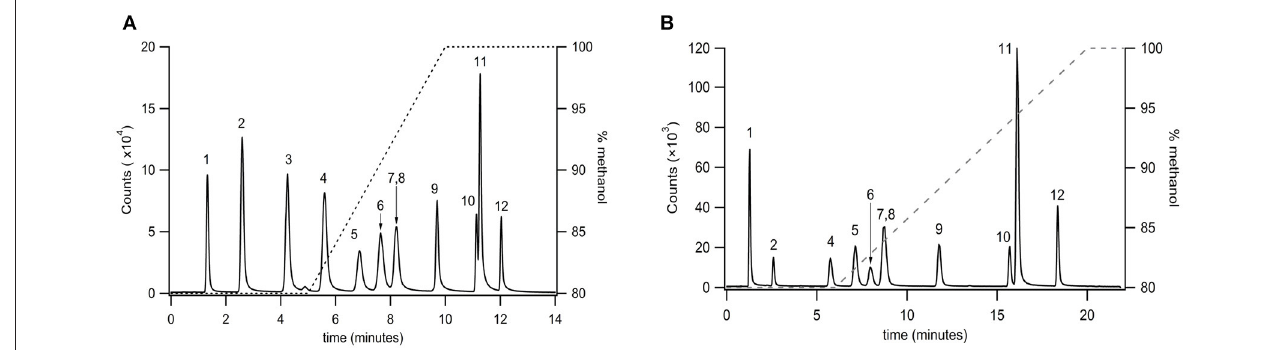
FIGURE 3 | Separation of very long chain PFAMs with Agilent RP C18 column (2.1 × 50mm, 1.8 µ m particle size) using a (A) steep and (B) shallow gradient (% methanol on the right axis). Peak identities were identified by MS/MS, with fractions ionized by APCI and identified in MRM mode. The peaks were identified as (1) lauramide, (2) myristamide, (3) linoleamide, (4) palmitamide, (5) oleamide, (6) elaidamide, (7) petroselaidamide, (8) heptadecanoamide, (9) stearamide, (10) erucamide, (11) arachidamide, (12) behenamide.